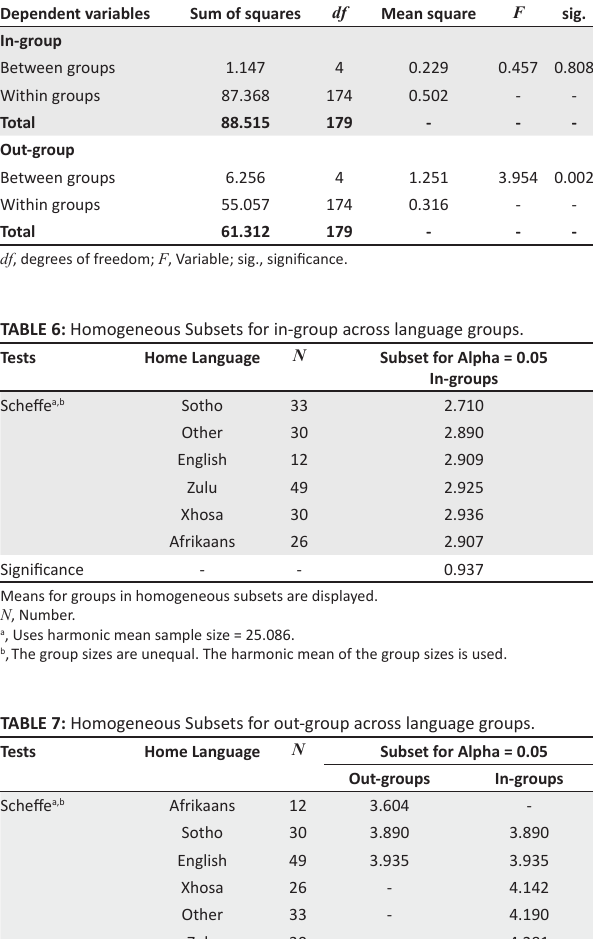
TABLE 5: ANOVA results for language groups.